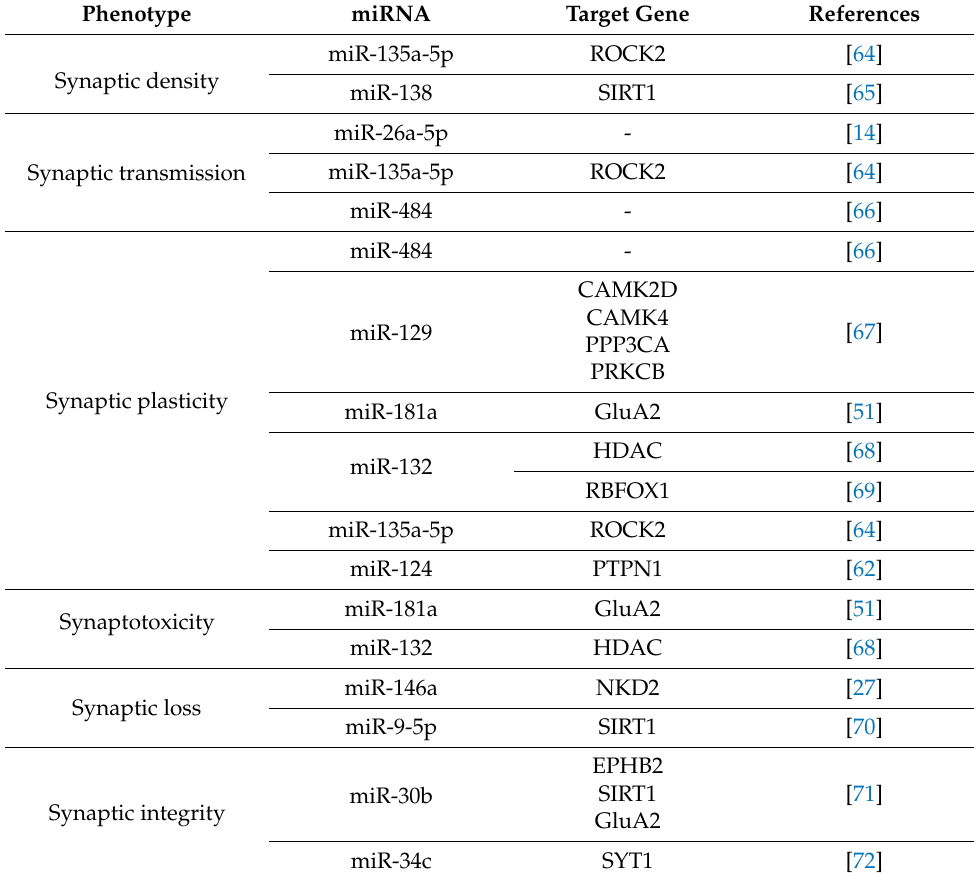
Table 1. Summary of studies implying miRNA in synapse-associated